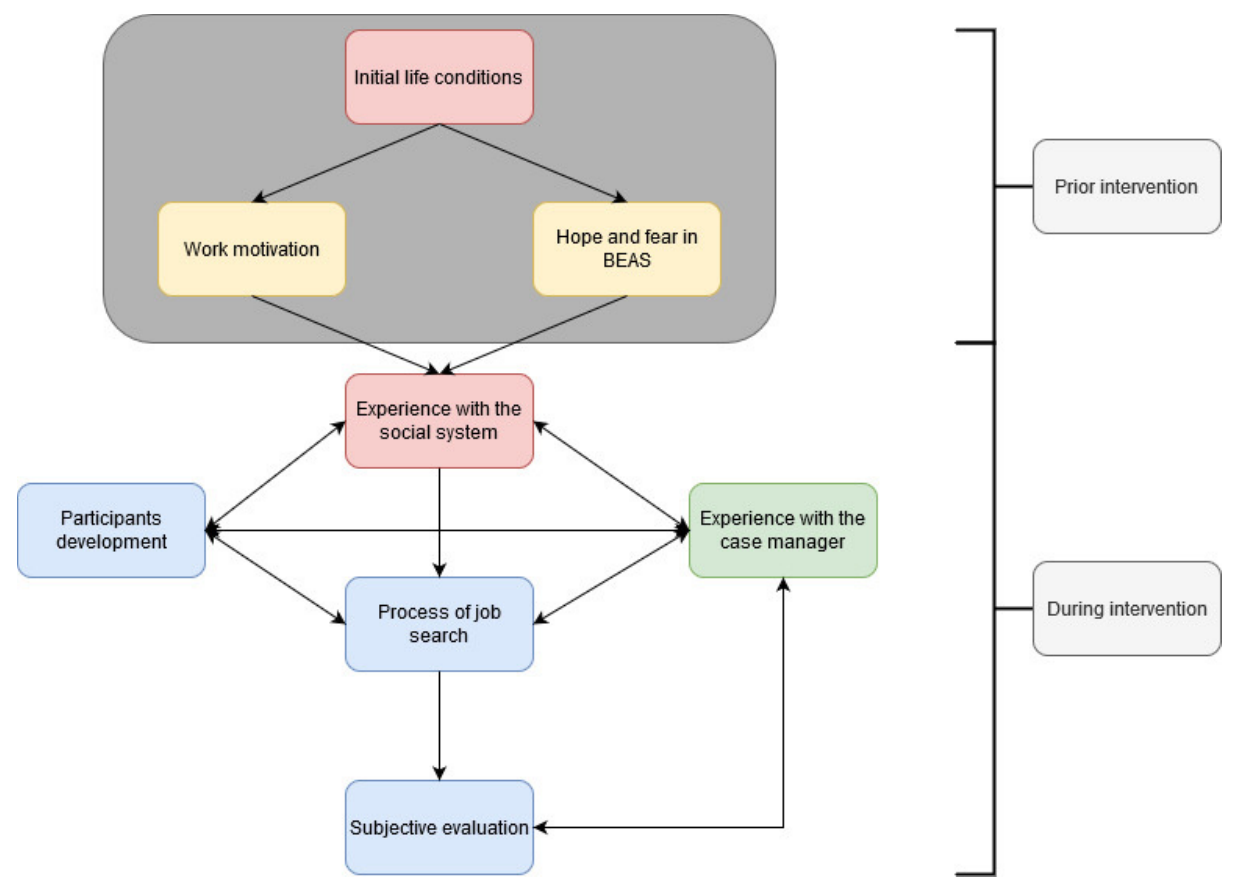
Figure 1. Relational category system based on the interviews and the existing literature. Blue: Category describing the experience of participants; green = category describing a perceived facilitator; red = category describing a perceived barriers; yellow = category describing a category that could be both, barrier and facilitator.